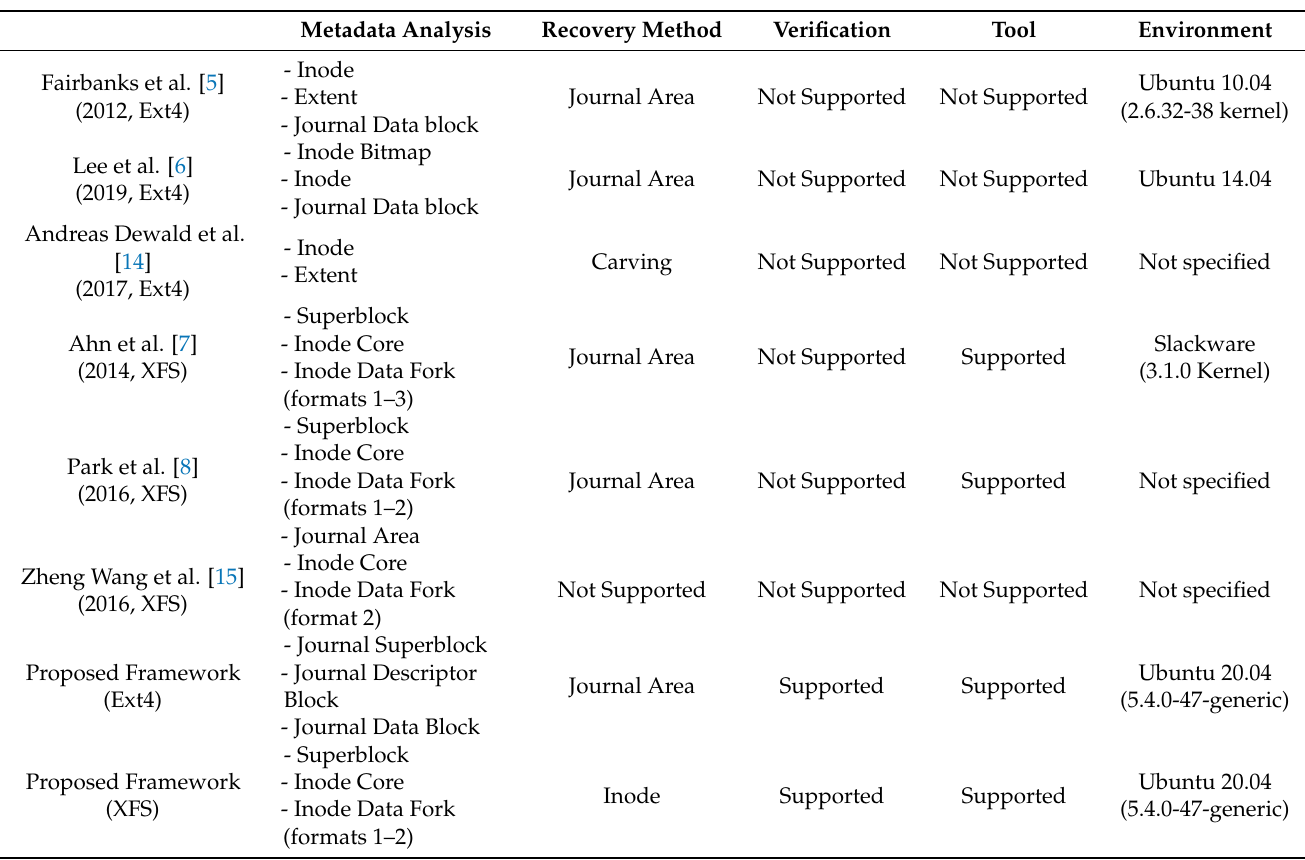
Table 1. Comparison of existing file extraction and recovery research with the proposed framework.